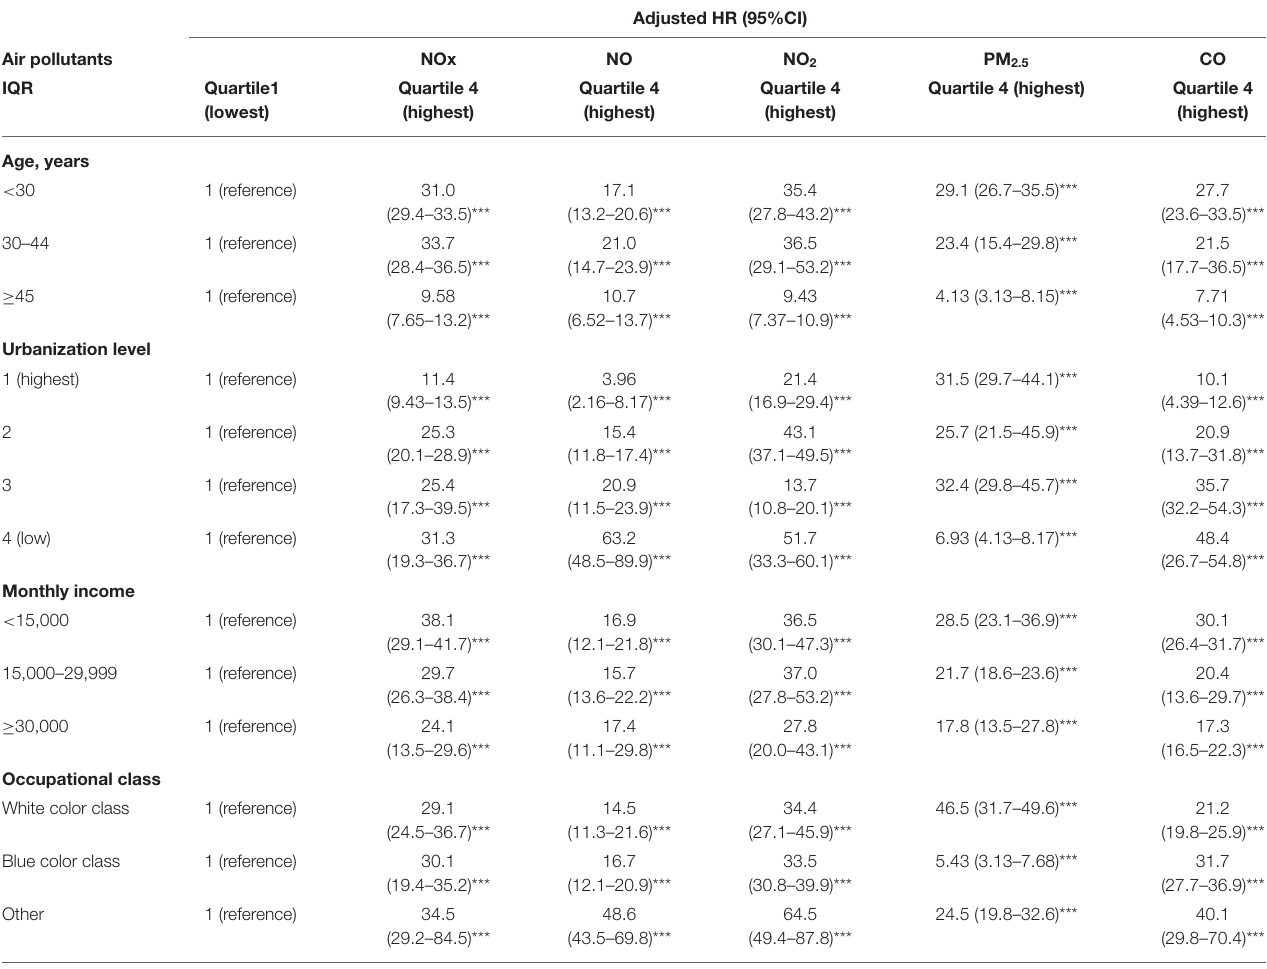
TABLE 3 | Incidence rate and hazard ratio of dysmenorrhea between various daily average concentrations of NOx, NO, NO 2 , PM 2.5 , CO stratified by gender, age, and comorbidities.